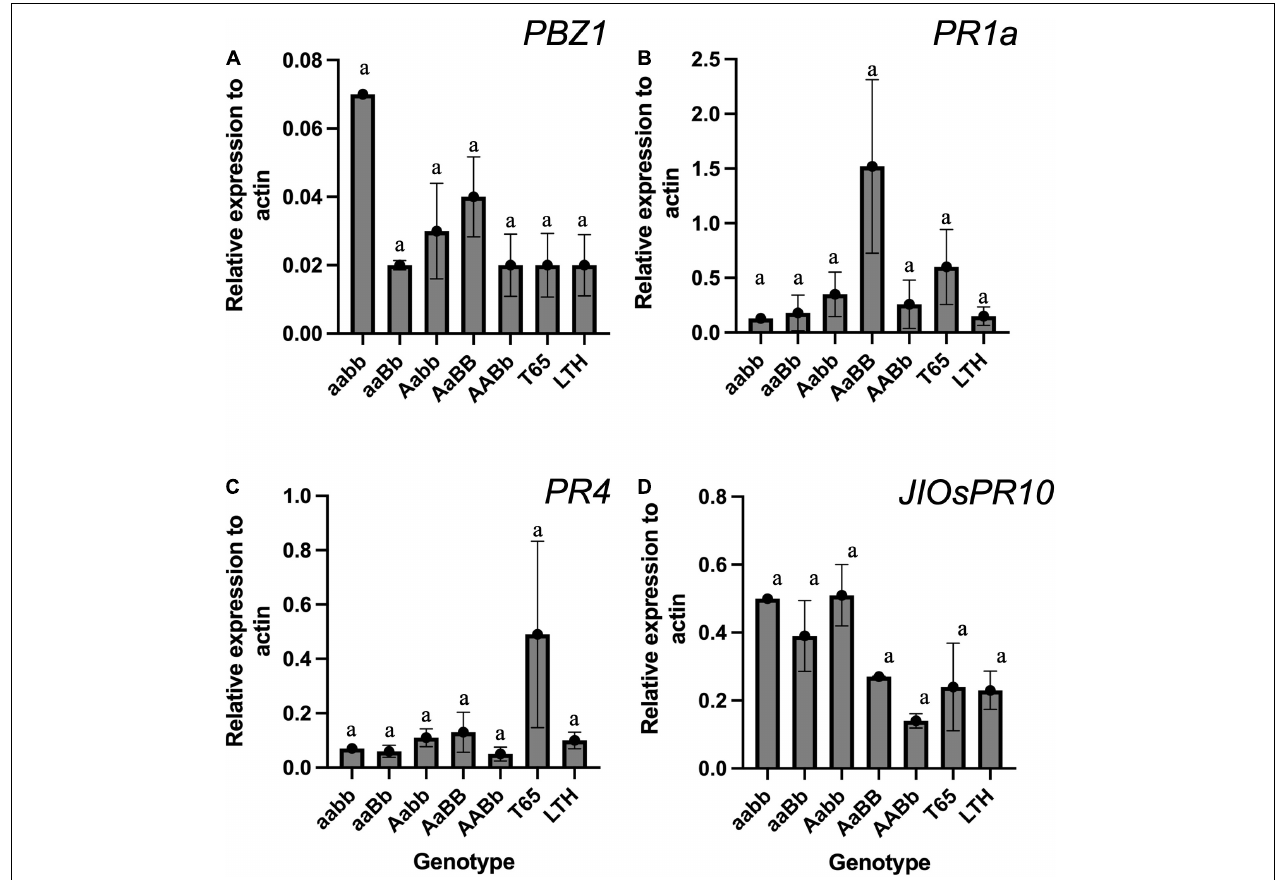
FIGURE 11 | The expression level of pathogen-related genes (PRs) in the leaf blades and sheaths of severe weak genotype ( aabb ), weak genotypes ( aaBb and Aabb ), normal genotype ( AaBB and AABb ), and the parents (T65 and LTH) at 7-day-old seedling stage. (A) PBZ1 , (B) PR1a , (C) PR4 , and (D) JIOsPR1 . Each qRT-PCR analysis was performed with three biological replications, but severe weak plants had no replication. Bars represent the means ± SE. Actin was used as the endogenous control for normalization.